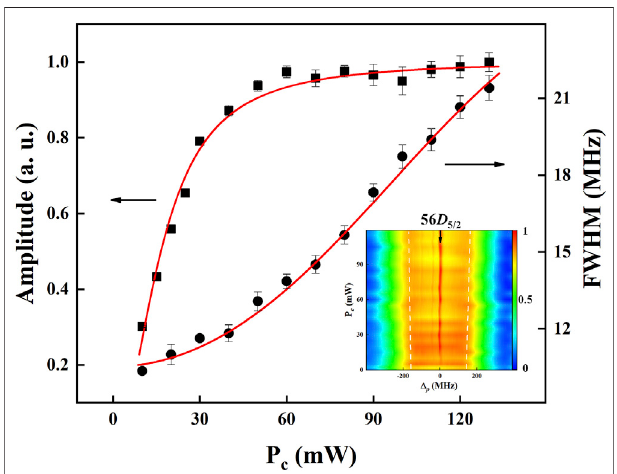
FIGURE 4 | Dependences of the amplitude (squares) and the FWHM (dots)ofCAEITonthecouplinglaserpower( P c ).Theredlinesaretheresultsof theoretical fi tting.The insetisthecontourplotsofthecorrespondingCAEITas afunctionof Δ p withdifferent P c .Theredareapointedbytheblackarrow in the inset represents the peak position of 5 S 1/2 – 56 D 5/2 transition, and the white lines are the trajectory of the two VRS peaks.